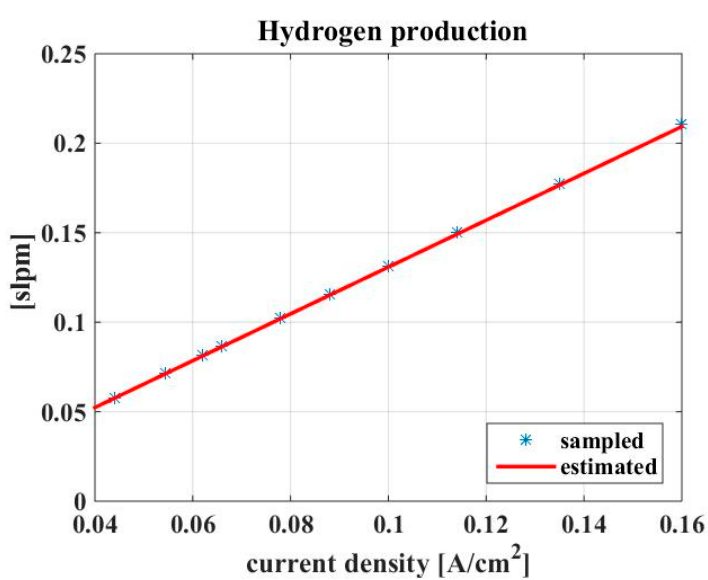
Figure 11. Upper limit of the of hydrogen production vs. current density.